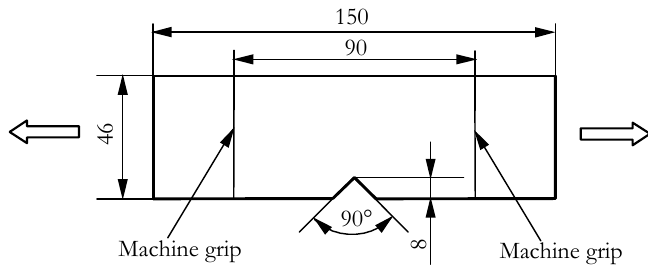
Figure 2: Specimens’ geometry (thickness 6 mm).